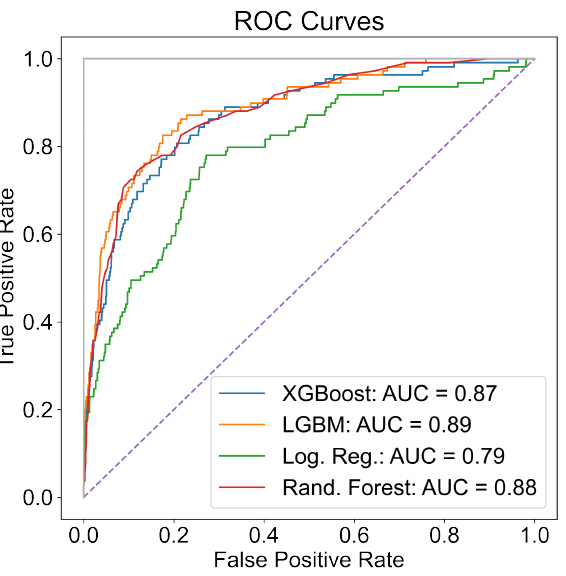
Figure 11. Performance of different machine learning models in identifying primary stage attrition. Similarly different machine learning models are evaluated to identify students that experienced attrition in either the intermediate or advanced stage after successfully complet- ing primary training. ROC curves for different models are shown in Figure 12. Again, XG Boost models seem to perform the best with an AUROC value of 0.92. Further, the weight hyper-parameter given to the positive class labels (attrition class) in the XG Boost model was varied, as shown in Figure 13, to determine the most optimal value. Results showed that a value between 1 and 25 led to improved AUROC values. For each positive or negative prediction, the probability of a positive prediction can also be simultaneously generated.